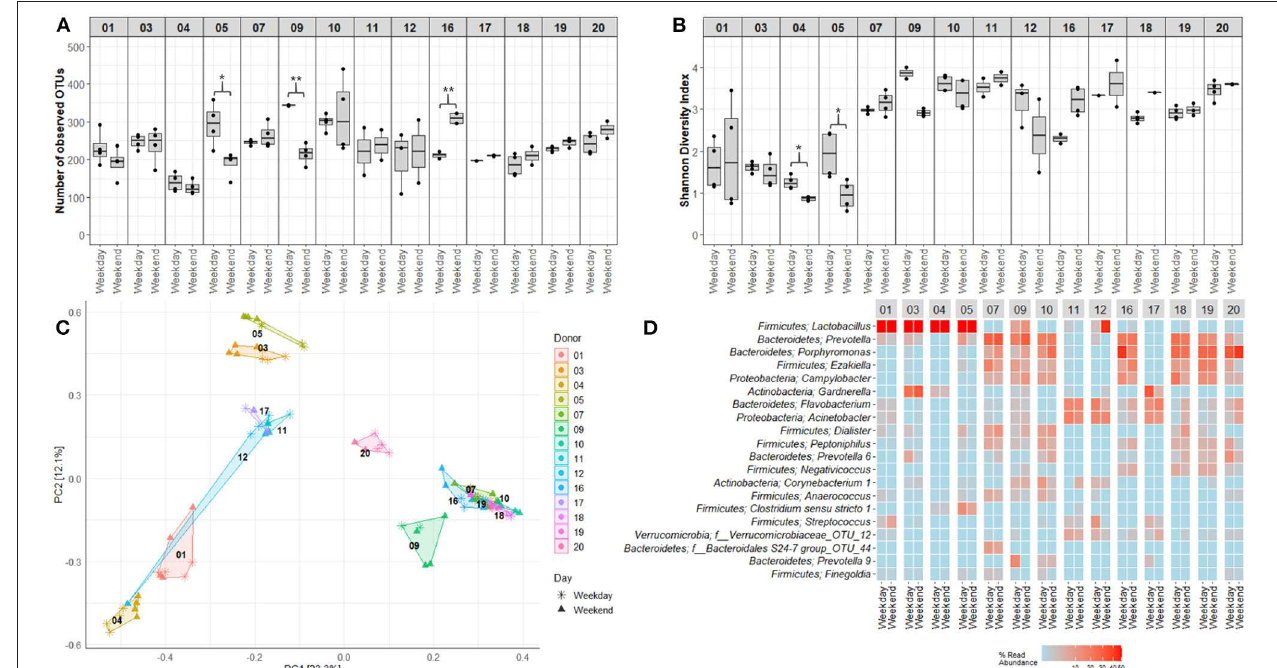
FIGURE 7 | Variations in voided urinary microbiota alpha and beta diversity between weekdays and weekends. (A) OTU richness showing numbers of unique OTUs in samples obtained at different days. (B) Shannon Diversity Index visualizing differences and similarities in diversity of OTUs. (C) Distribution of samples collected at different days, using PCA of Hellinger transformed OTU abundances. Colors and numbers indicate study participant while point shape indicate collection day. (D) Heat maps depicting the 20 most common OTUs at different collection days. Each name consists of phylum followed by genus name. If no genus could be identified, the best taxonomic assignment is listed. For this part of the study, three donors, one girl (donor 8) and two men (donors 13 and 15), were excluded since a complete set of matching weekday-weekend samples were lacking. Donors 01–05 were adult women (18–50 years), 06–10 girls (5–10 years), 11–15 adult men (18–50 years), and 16–20 were boys (5–10 years). * p < 0.05, ** p < 0.01.